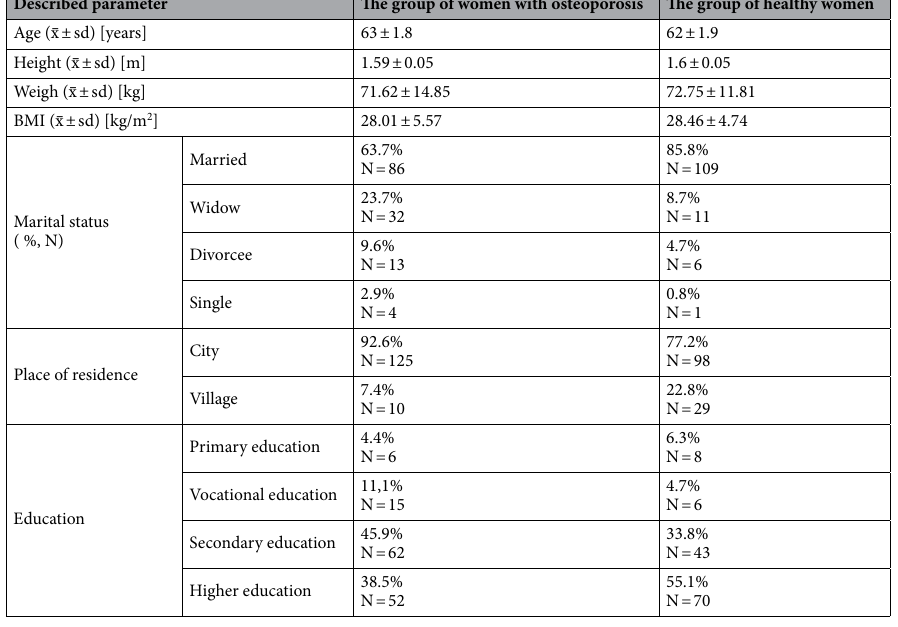
Table 2. Basic characteristic.